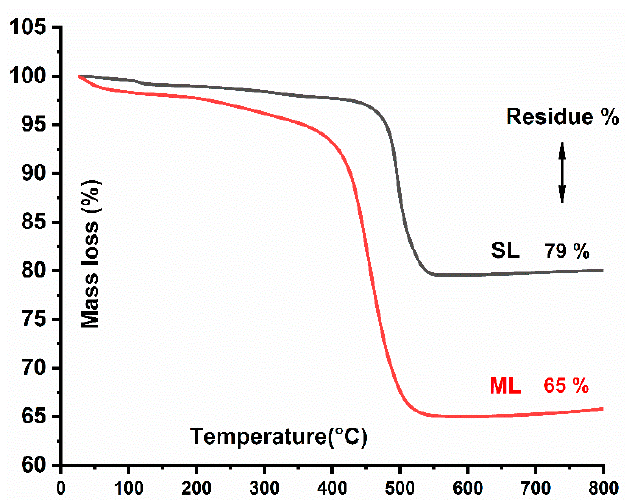
Figure 9. Thermogravimetric analysis of single-layer (SL) and multilayer (ML) coatings.